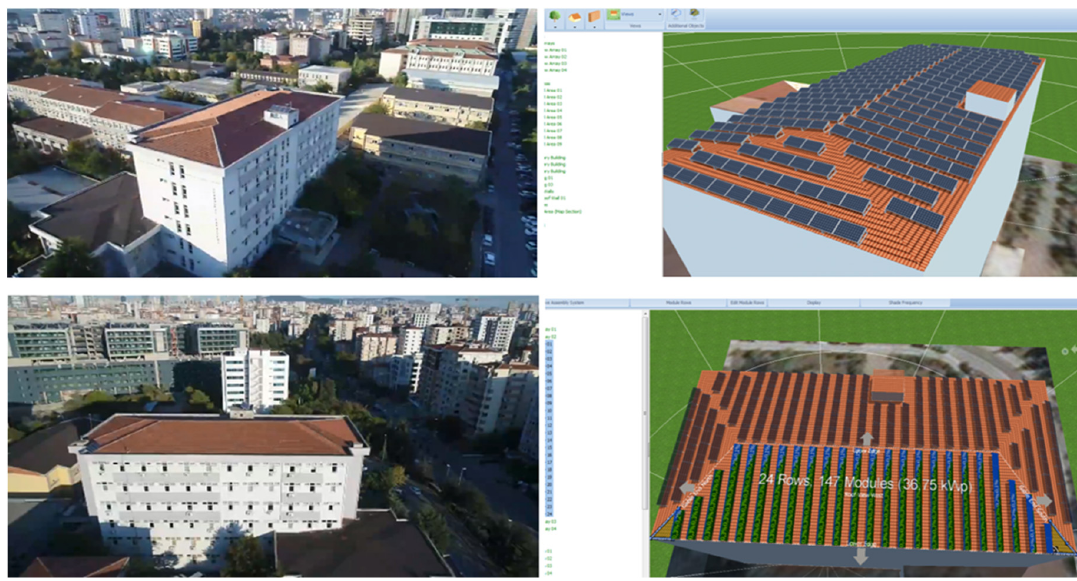
Figure 8. Faculty building and its 3D model mounted-roof PV panels.